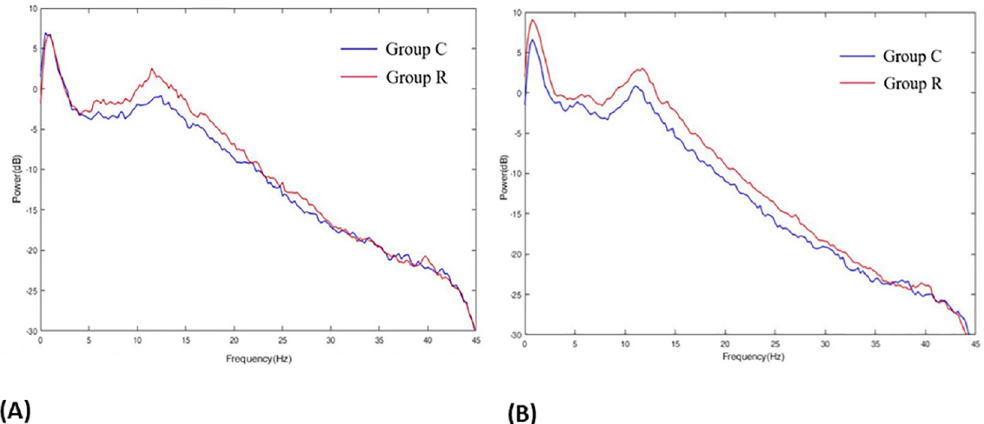
Fig 5. Power spectra at TR0 (A) and TR4 (B) comparing group C with group R. The power spectra for each group were plotted at TR0 (A) and TR4 (B) separately to determine the effect of NMB; changes in the slow and delta frequency bands were observed at TR4 compared to TR0 in group